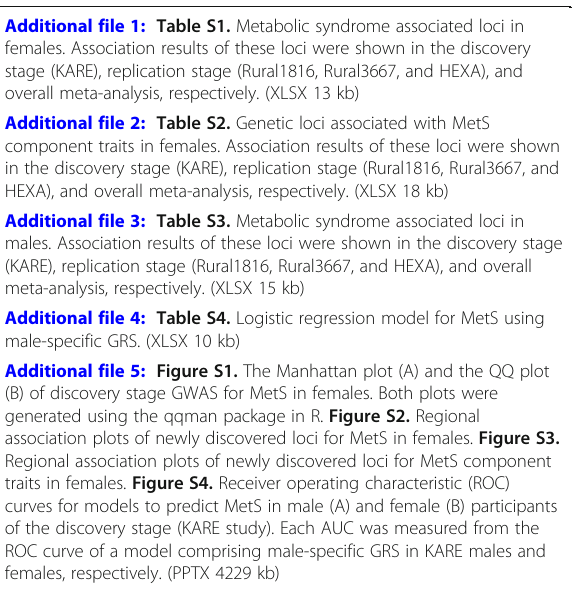
Additional file 1: Table S1. Metabolic syndrome associated loci in females. Association results of these loci were shown in the discovery stage (KARE), replication stage (Rural1816, Rural3667, and HEXA), and overall meta-analysis, respectively. (XLSX 13 kb) Additional file 2: Table S2. Genetic loci associated with MetS component traits in females. Association results of these loci were shown in the discovery stage (KARE), replication stage (Rural1816, Rural3667, and HEXA), and overall meta-analysis, respectively. (XLSX 18 kb) Additional file 3: Table S3. Metabolic syndrome associated loci in males. Association results of these loci were shown in the discovery stage (KARE), replication stage (Rural1816, Rural3667, and HEXA), and overall meta-analysis, respectively. (XLSX 15 kb) Additional file 4: Table S4. Logistic regression model for MetS using male-specific GRS. (XLSX 10 kb) Additional file 5: Figure S1. The Manhattan plot (A) and the QQ plot (B) of discovery stage GWAS for MetS in females. Both plots were generated using the qqman package in R. Figure S2. Regional association plots of newly discovered loci for MetS in females. Figure S3. Regional association plots of newly discovered loci for MetS component traits in females. Figure S4. Receiver operating characteristic (ROC) curves for models to predict MetS in male (A) and female (B) participants of the discovery stage (KARE study). Each AUC was measured from the ROC curve of a model comprising male-specific GRS in KARE males and females, respectively. (PPTX 4229 kb) Abbreviations AUC: Area under the curve; DBP: Diastolic blood presure; FPG: Fasting plasma glucose; GRS: Genetic risk score; GWAS: Genome-wide association